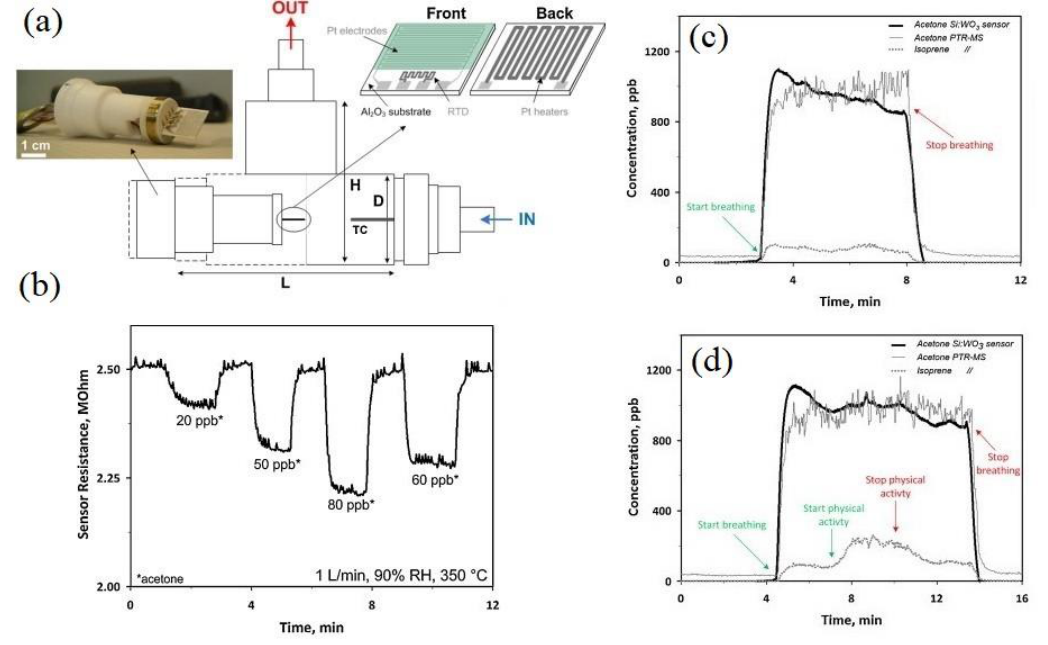
Figure 6. ( a ) Schematic of gas chamber used for breath analysis. ( L = 75, H = 50, and D = 18 mm, thermocouple (TC). ( b ) Dynamic resistance curve of 10 mol% Si-doped WO 3 gas sensor to low concentrations of acetone under 90% RH at 350 °C. ( c ) Dynamic resistance curves of the Si:WO 3 sensor (thick solid line), acetone (thin solid line), and isoprene (dotted line) gas tested using proton transfer reaction mass spectrometry (PTR-MS) through breathing of a test person ( c ) at rest and ( d ) during physical activity [115]. Reprint permission was obtained from Elsevier.